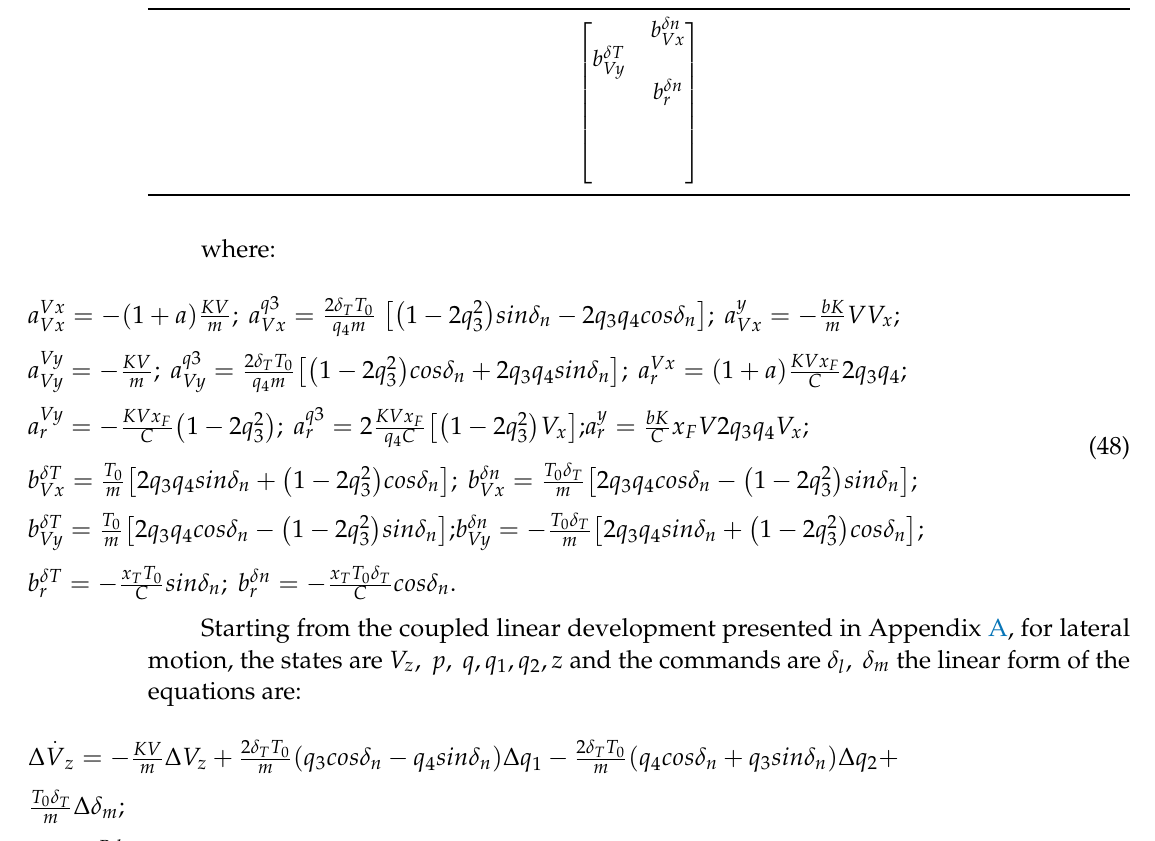
Table 6. Command matrix for longitudinal motion in horizontal evolution B